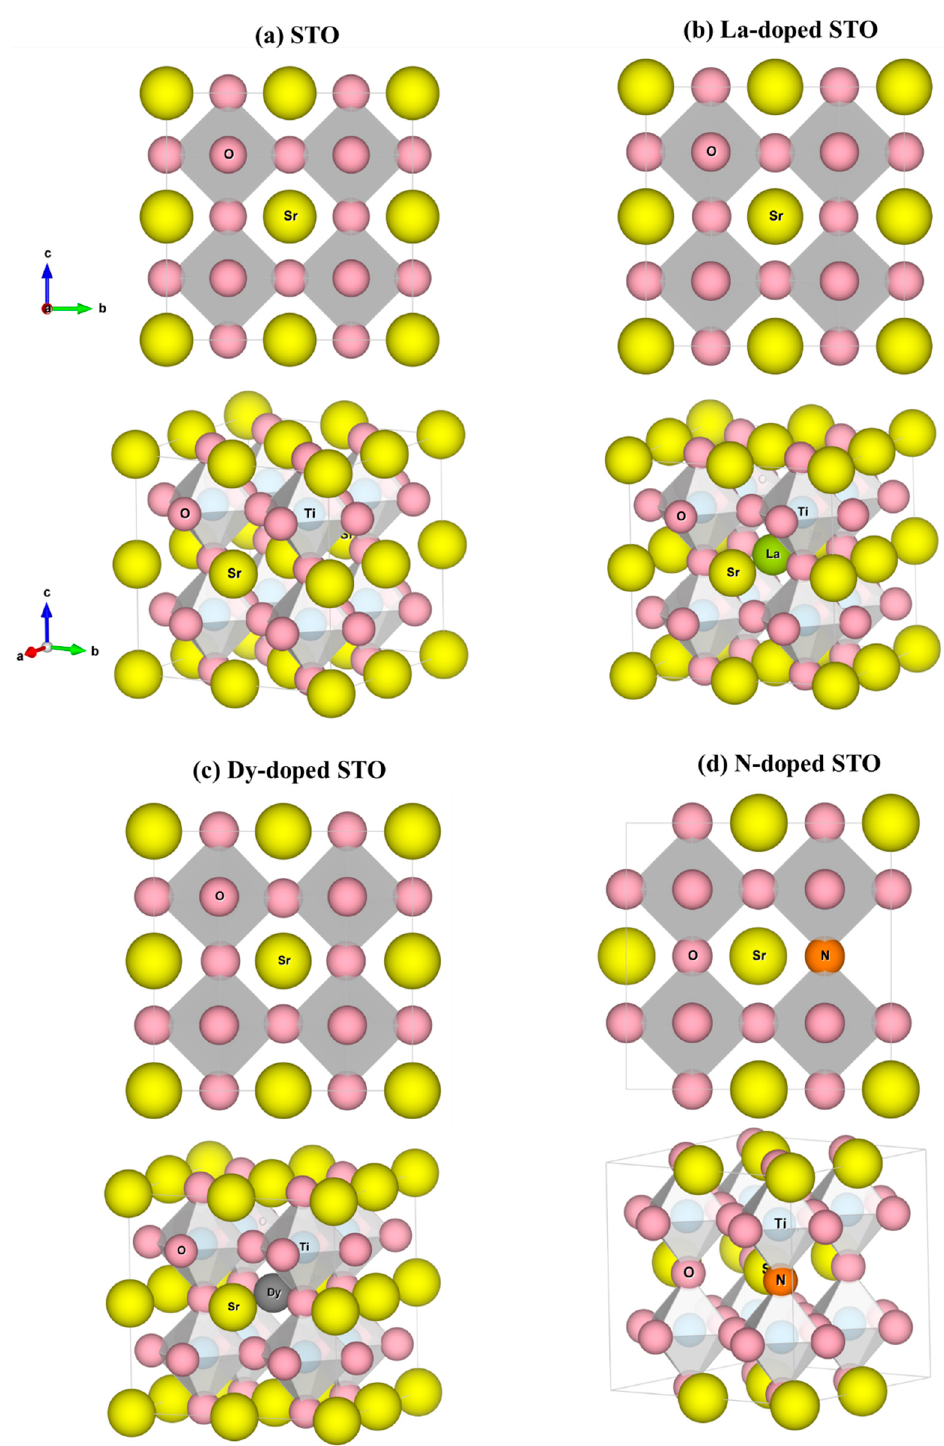
Figure 1. Optimized structures of ( a ) undoped SrTiO 3 , ( b ) La-doped SrTiO 3 , ( c ) Dy-doped SrTiO 3 and ( d ) N-doped SrTiO 3 . Yellow spheres represent Sr atoms, blue are Ti, pink are O, green are La, grey are Dy, and orange are N.